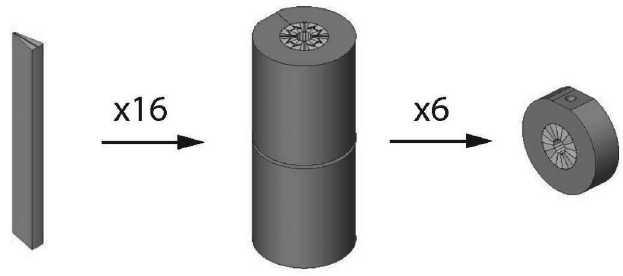
FIG. 13. An illustration of the PMQ manufacturing process.